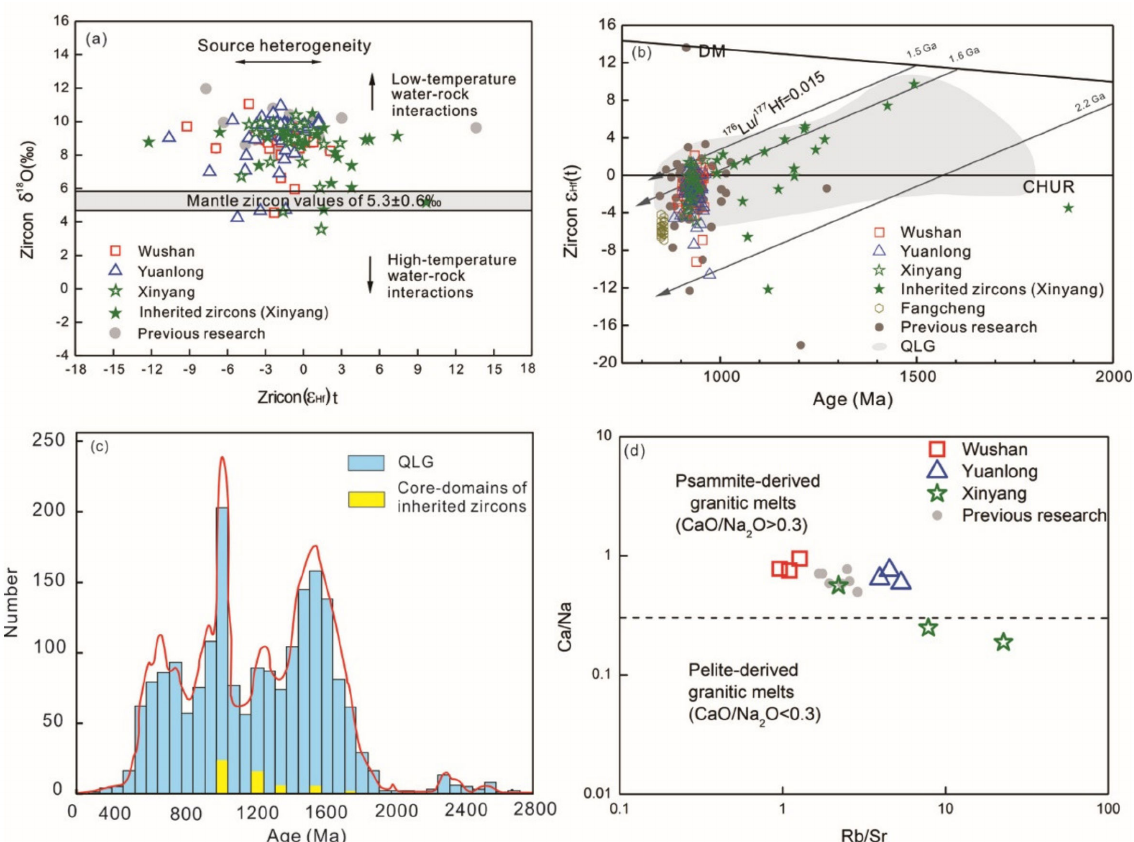
Figure 11. ( a ) Plot of δ 18 O versus ε Hf (t) for zircons from Neoproterozoic granitic rocks from the QOB. The data source for the previous research: [41]. ( b ) Plot of ε Hf (t) versus U–Pb age for zircons from the studied Neoproterozoic granitic mylonites from Wushan and granitic gneisses from Yuanlong and Xinyang in the western margin of the NQT as well as gneisses from the Qinling Group (QLG) in the NQT. Data sources: Fangcheng [51]; previous research for the biotite monzonitic gneiss and granites from Fangzhuang, Zhaigen, and Dehe [20,41] and the QLG [99,100]. ( c ) U–Pb zircon age histogram with a probability density plot for the QLG and comparison with ages from the core domains of inherited zircons of this study. Data sources for the QLG: [99,100,106–109]. ( d )